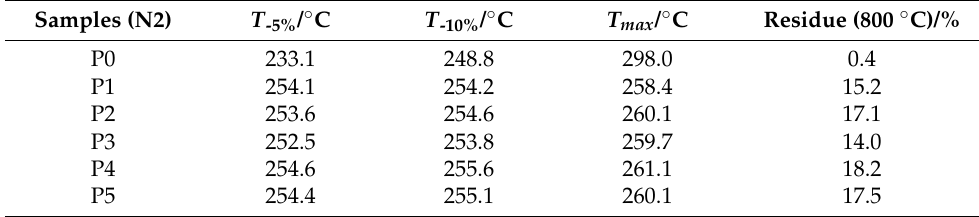
Figure 8. TG and DTG curves of FR-POM composites under N 2 ( a , b ) and AIR ( c , d ) atmospheres. Table 4. Thermogravimetric data of FR-POM composites under nitrogen atmosphere.